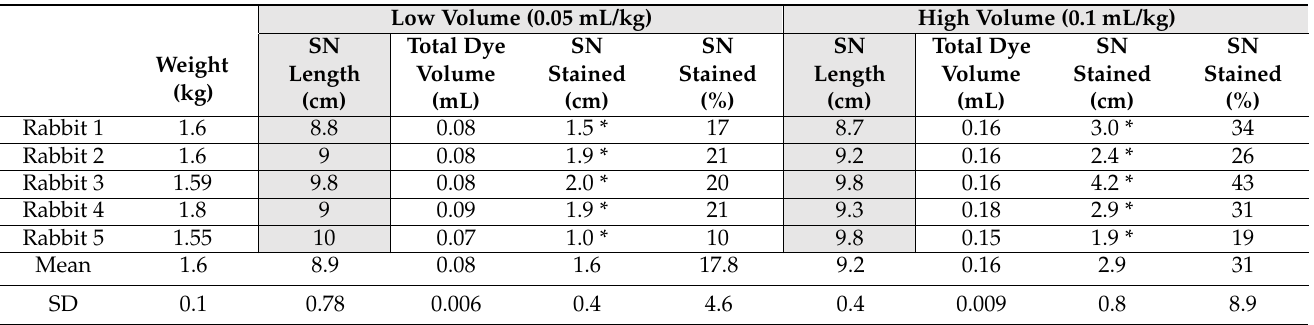
Table 1. Evaluation of the extent of nerve staining obtained by performing ultrasound-guided saphenous nerve (SN) blocks using a dye solution [permanent yellow tissue dye in lidocaine 2% (1:50)] in five rabbit cadavers (10 hind-limbs) with either low (0.05 mL/kg) or high (0.1 mL/kg) volume. Values (mean ± standard deviation) are reported for saphenous nerve total length, the length of the staining obtained, the total volume of dye solution injected for each hind-limb, and the percentage of the total length of saphenous nerves stained. SD: standard deviation; * The difference between the length of the SN nerves staining obtained using low or high volumes of dye solution was statistically significant ( p = 0.0476; Fisher’s Exact test). The background colour is necessary to distinguisci between the tho nerves ot the two different legs of the same